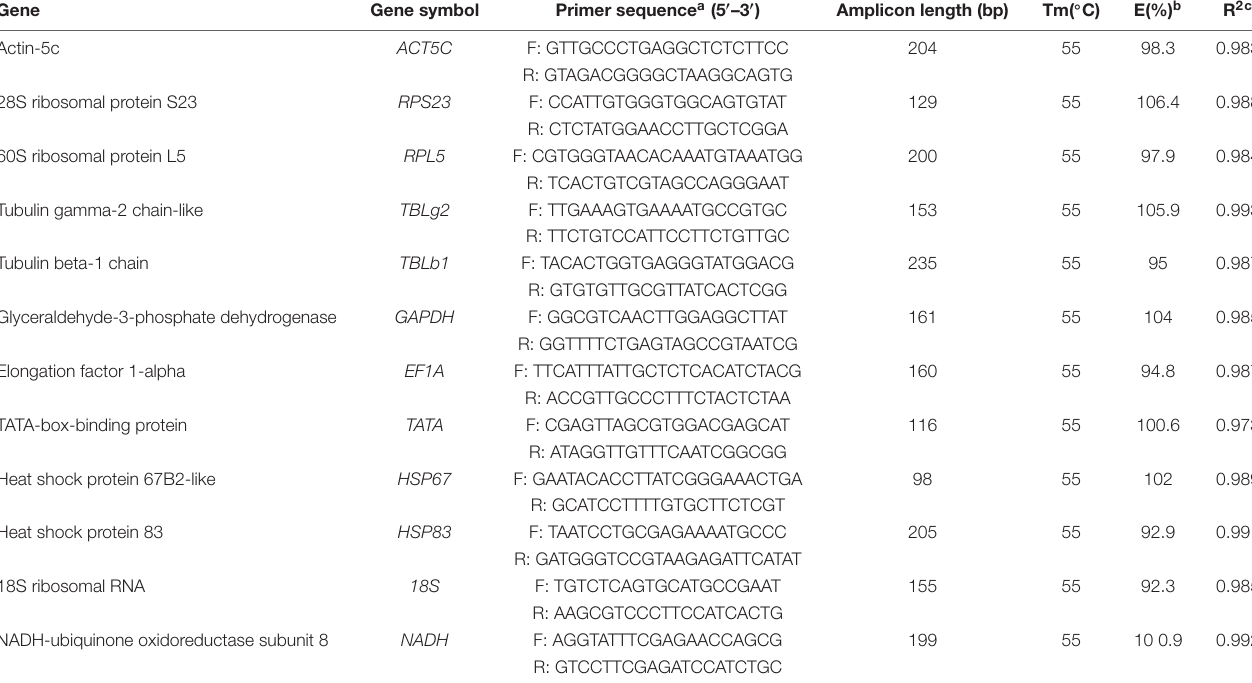
a F and R indicate forward and reverse primers, respectively. b RT-qPCR efficiency, calculated by the standard curve method. c Determination coefficient.